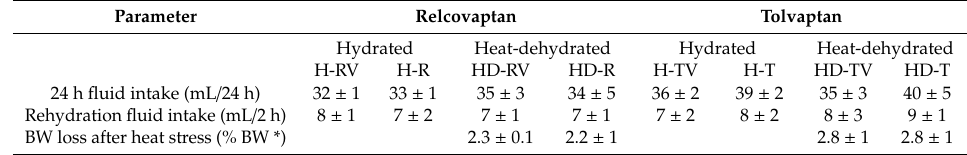
Table 1. Twenty-four-hour fluid intake, rehydration fluid intake, and body weight loss after heat stress. Parameter Relcovaptan Tolvaptan Hydrated Heat-dehydrated Hydrated Heat-dehydrated H-RV H-R